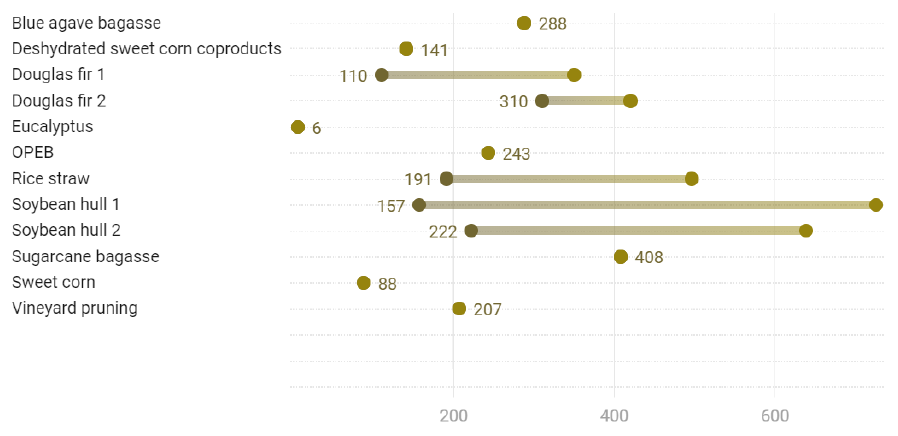
Figure 9. Specific mechanical energy for some lignocellulosic biomass extrusion